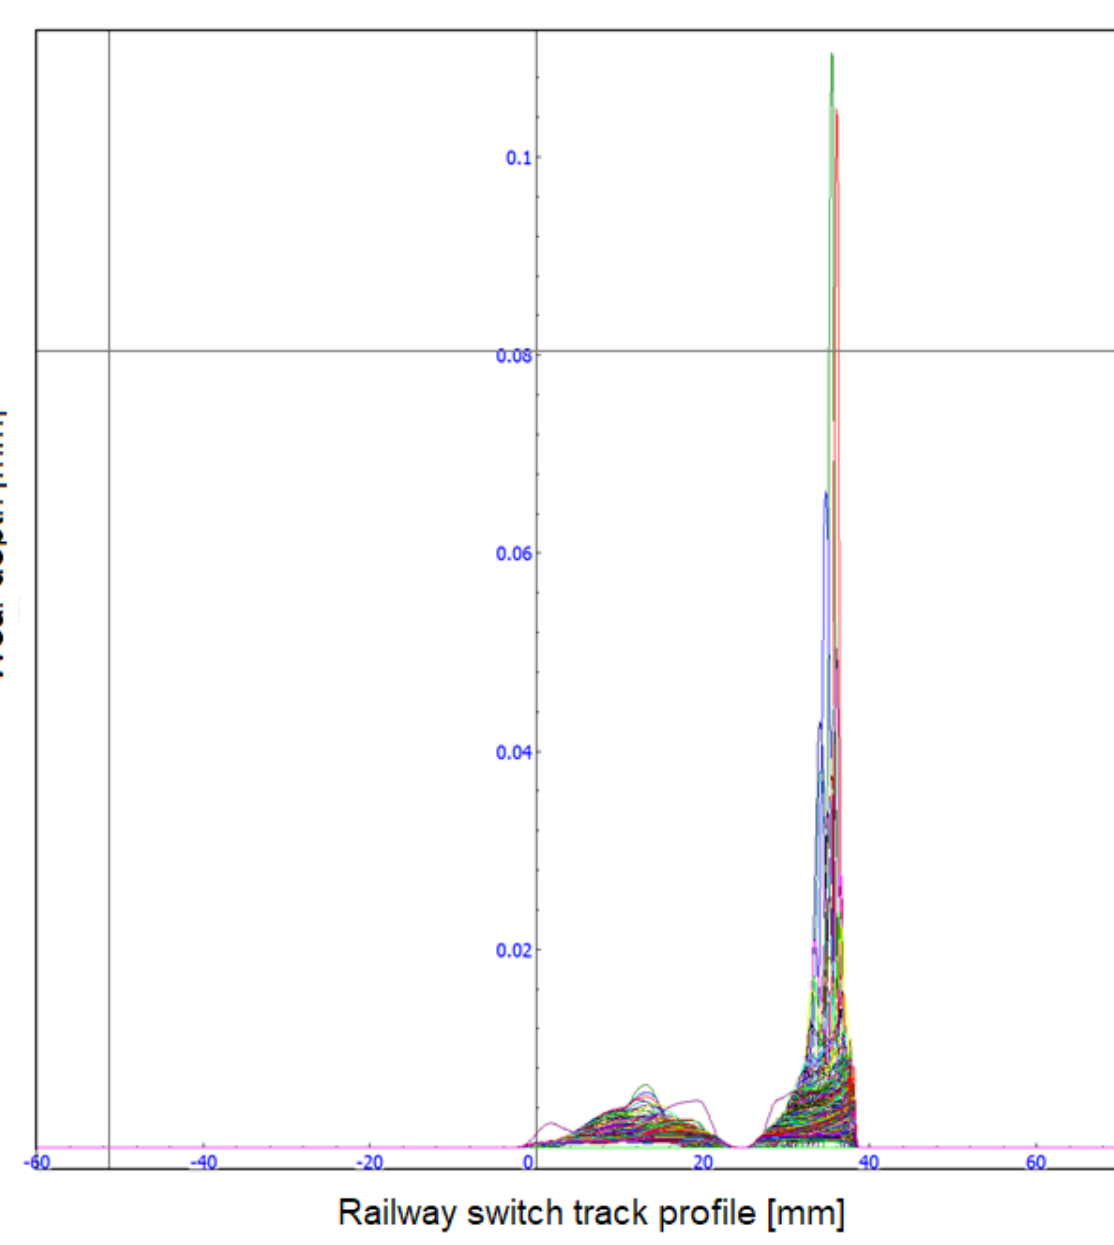
Figure 43. Wheel wear at 350 km/h for straight-track traffic through a turnout.